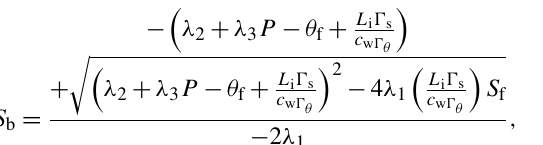
where m is the melt rate at the ice-shelf base or the freez- ing rate at the sea surface; the subscripts w and i refer to the parameters for water and ice, respectively. The parameters values are listed in Table 1. The friction velocity at the ice- shelf base was calculated from the simulated velocity